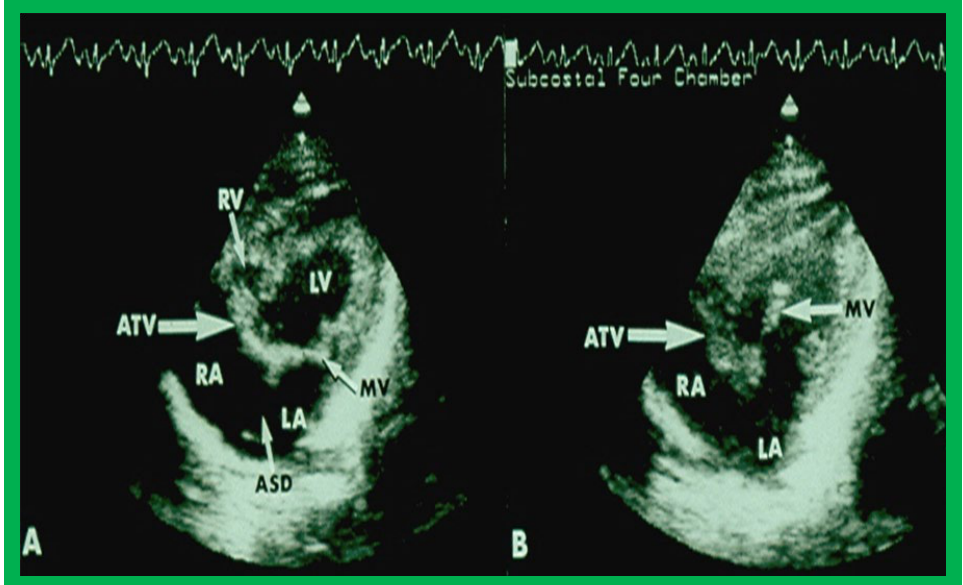
Figure 4. Selected video frames from subcostal four chamber view of a two dimensional echocar- diographic study demonstrating an atretic tricuspid valve (ATV) (thick arrow), represented by a dense band of echoes between the right atrium (RA) and hypoplastic right ventricle (RV). In ( A ), the mitral valve (MV) is closed while in ( B ), it is open. Note the improvement from the pictures shown in Figure 2. LA, left atrium; LV, left ventricle. Reproduced from Reference [27].